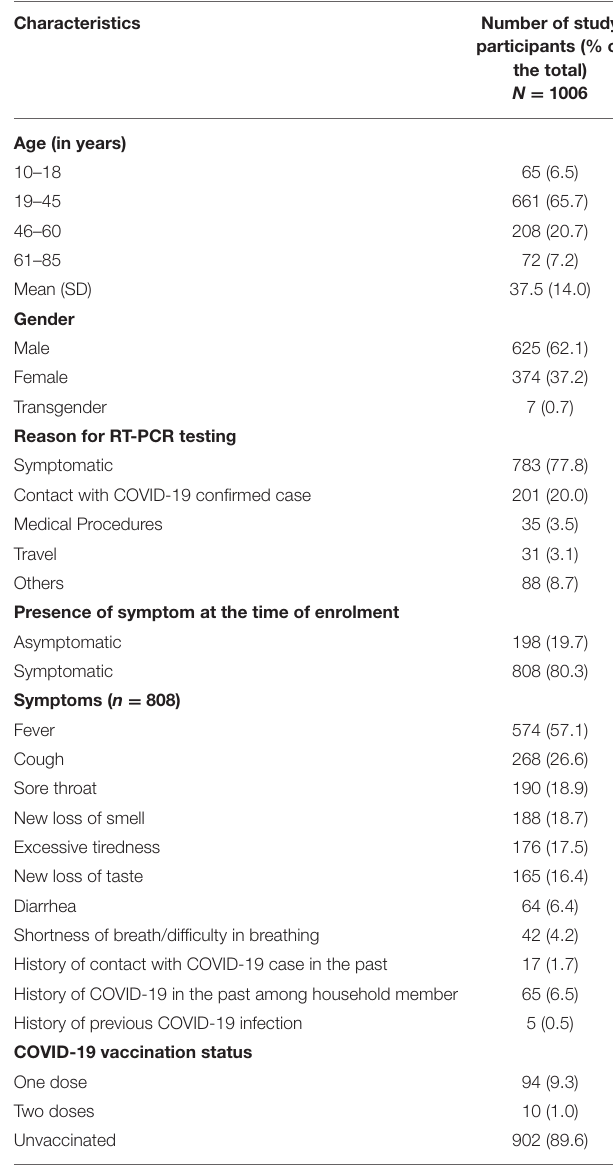
TABLE 1 | Demographic and clinical characteristics of the study